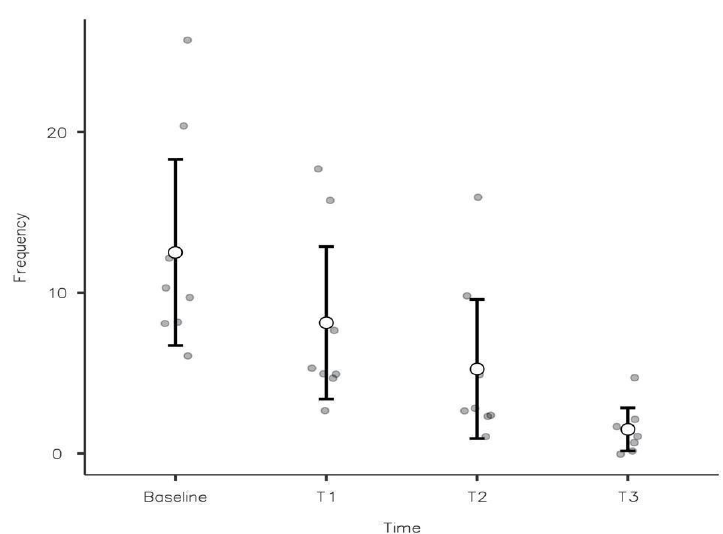
Figure 1. Significant reduction in the frequency of behavioral symptoms during web-based treatment with the BST approach.